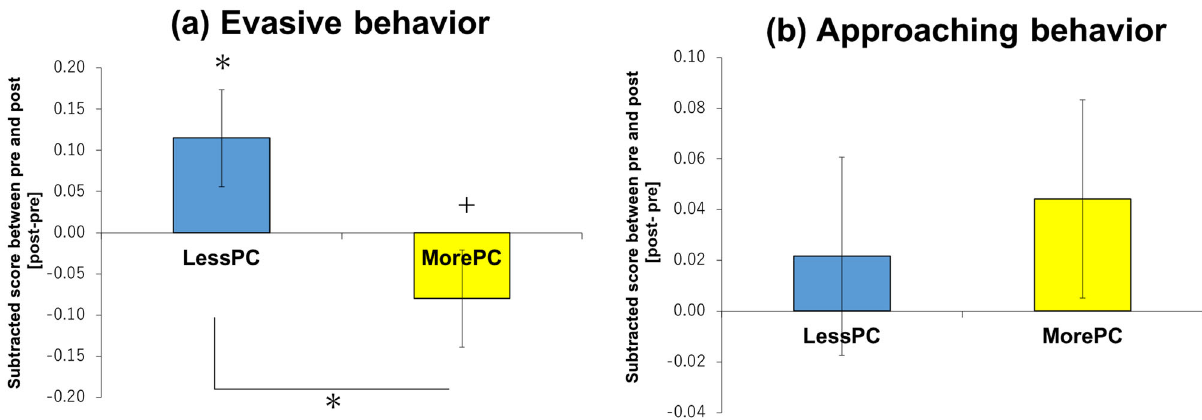
Fig. 1 The results of the Stranger Approach Task. The differential score of infants ’ reaction to a stranger approach: a Evasive Behavior, b Approaching Behavior. Error bar shows standard errors. * p < 0.05, + p < 0.10.